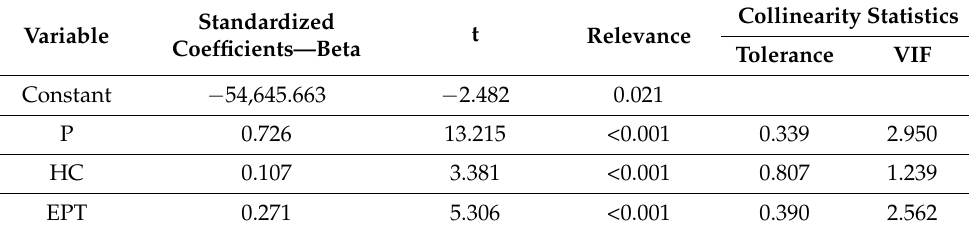
Table 8. Coefficients in the regression model of greenhouse gas emissions in 2016.